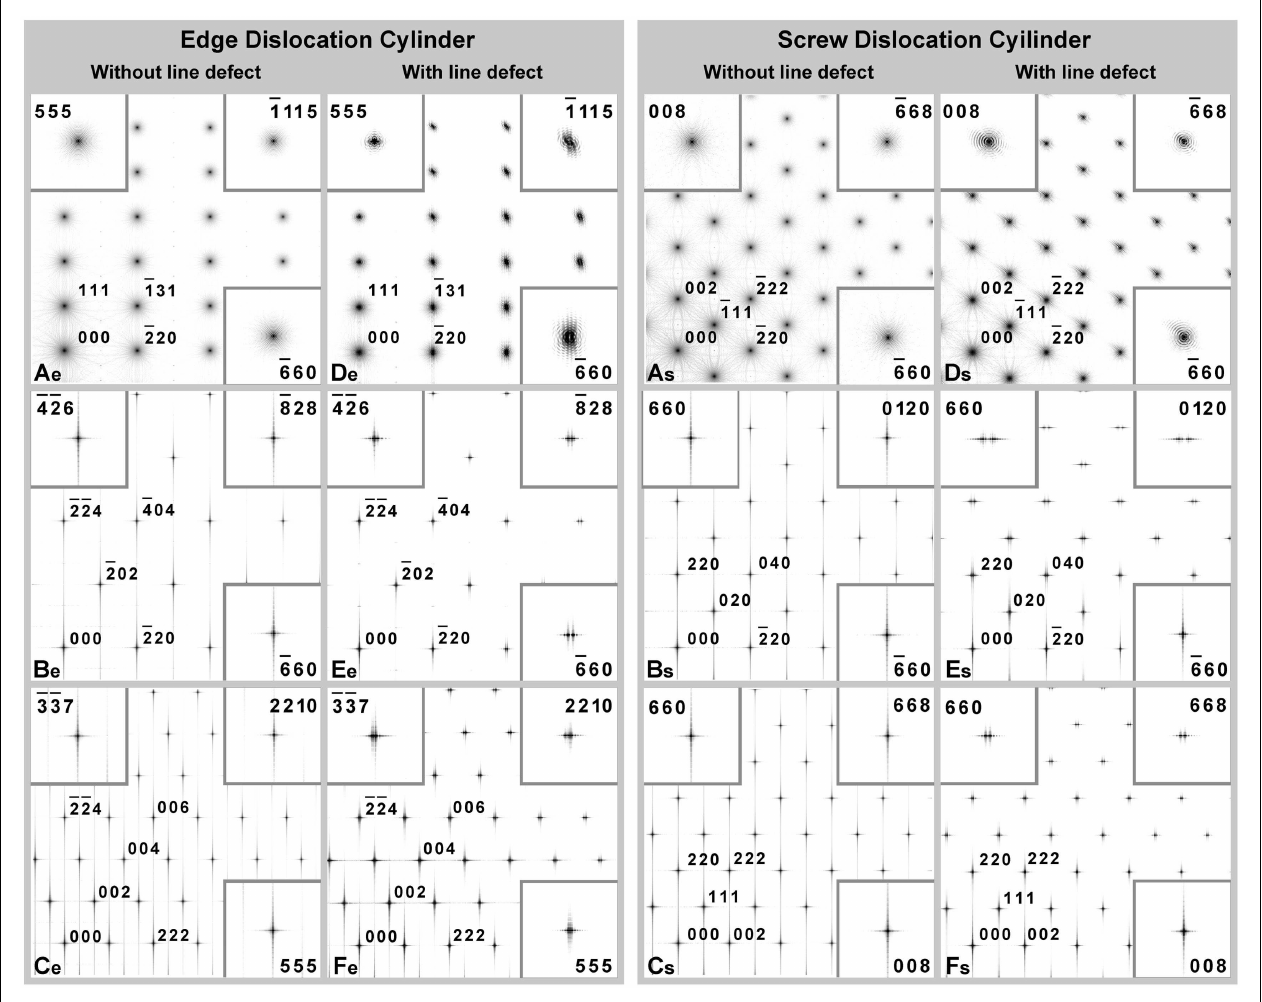
(D s , E s , and F s ). XRD intensity from corresponding cylinders without line defects are shown in (A e , B e , and C e ) and (A s , B s , and C s ). Refer to Figure 1 for details on the cylindrical